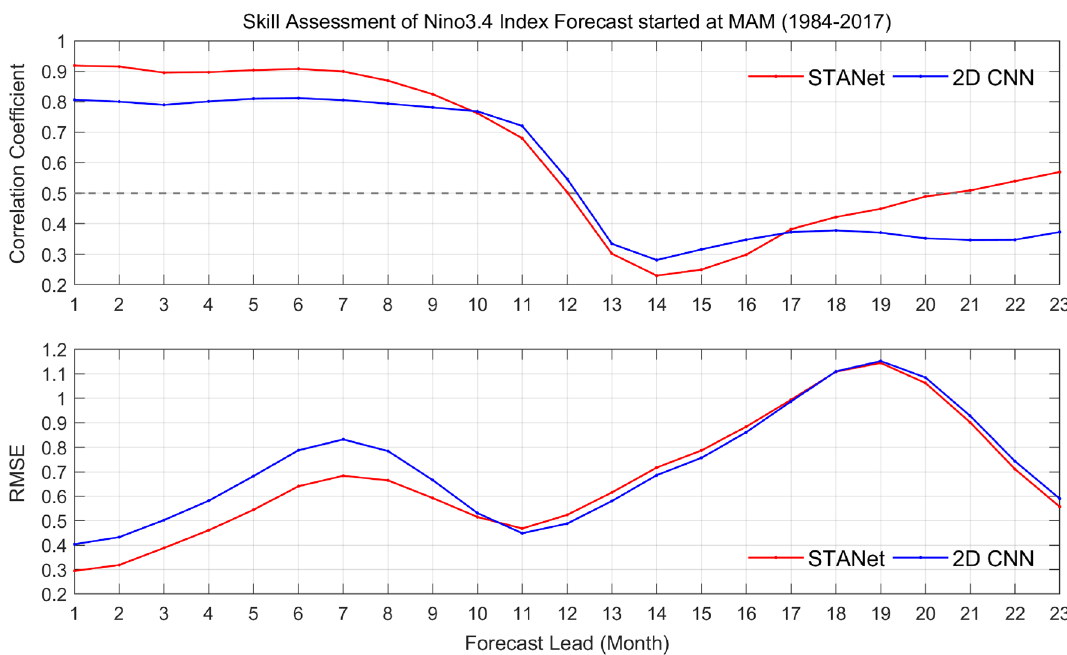
Figure 3. Time series of of correlation coefficient ( CC ) and the root-mean-square-error ( RMSE ) for 23-month forecast lead time of the proposed STANet and the state-of-the-art 2D CNN model for forecasts employing input data from the March–April–May (MAM)